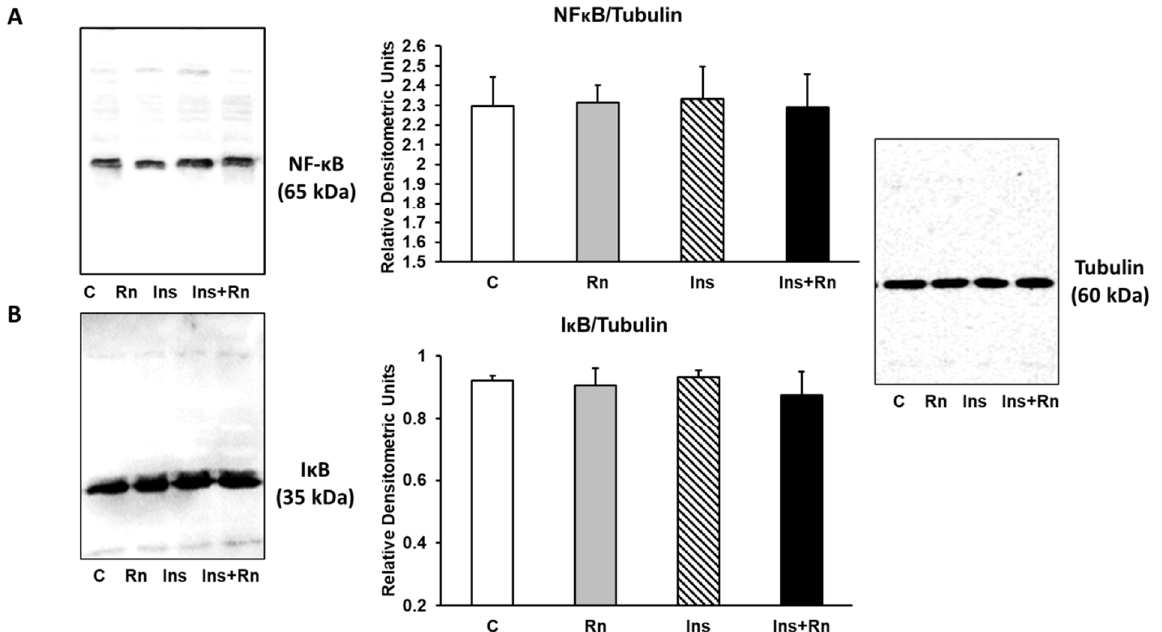
Figure 8. Effect of Ins and Rn on NF κ B ( A ) and I κ B ( B ) protein expression. Astrocytes were incubated without Ins or Rn (control, C), with Rn (10 − 6 M), with Ins (10 − 8 M), or with Ins + Rn (10 − 8 M + 10 − 6 M) for 24 h and collected to determine NF κ B (1:250) ( A ) and I κ B (1:250) ( B ) protein expression by Western-blot. Tubulin (1:3000) was added in both figures as loading control). Representative immunoblots are shown in the panels. Data are mean ± SD of four independent experiments (four different rats).